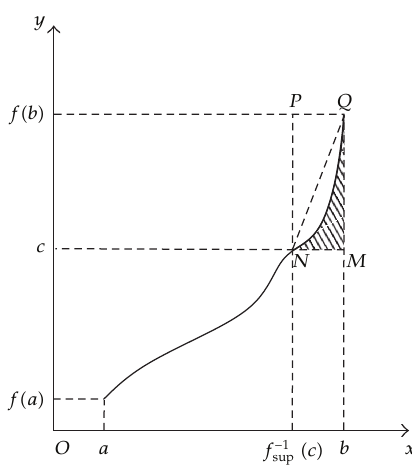
Figure 5: The geometry of the case c ≤ f (cid:5) b (cid:4) .